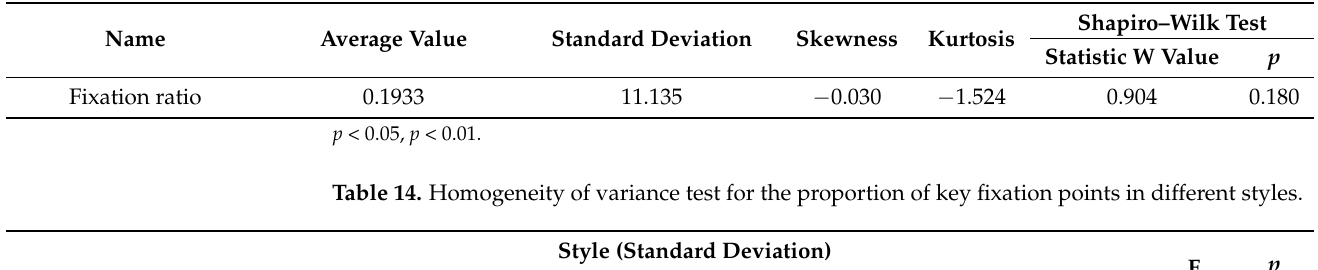
Table 13. Data normality test for different styles of button fixation duration.